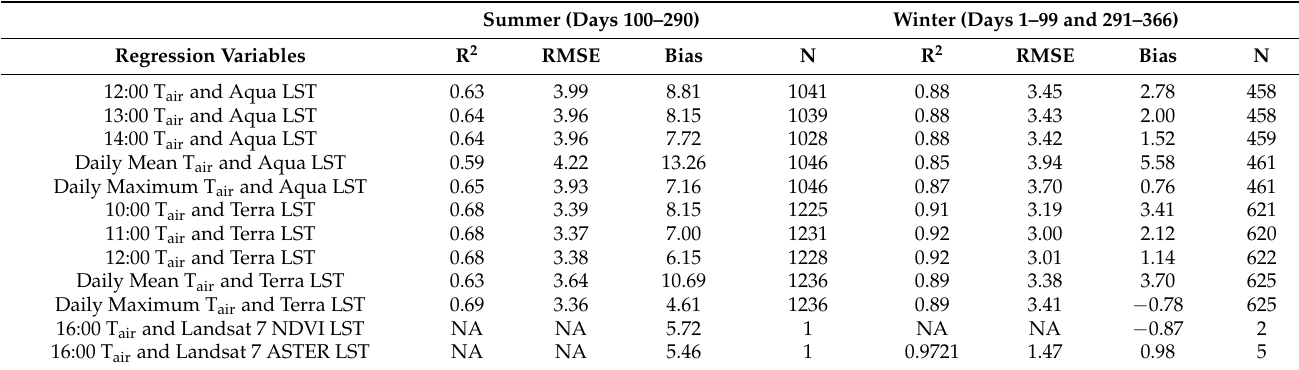
Table 7. Detailed results from regression analyses conducted using both MODIS satellites and Landsat 7 against air temperature based on wetland in situ stations. All MODIS p -values are <0.001 (with Landsat 7, it is NA). Summer (Days 100–290) Winter (Days 1–99 and 291–366) Regression Variables R 2 Bias 12:00 T air and Aqua